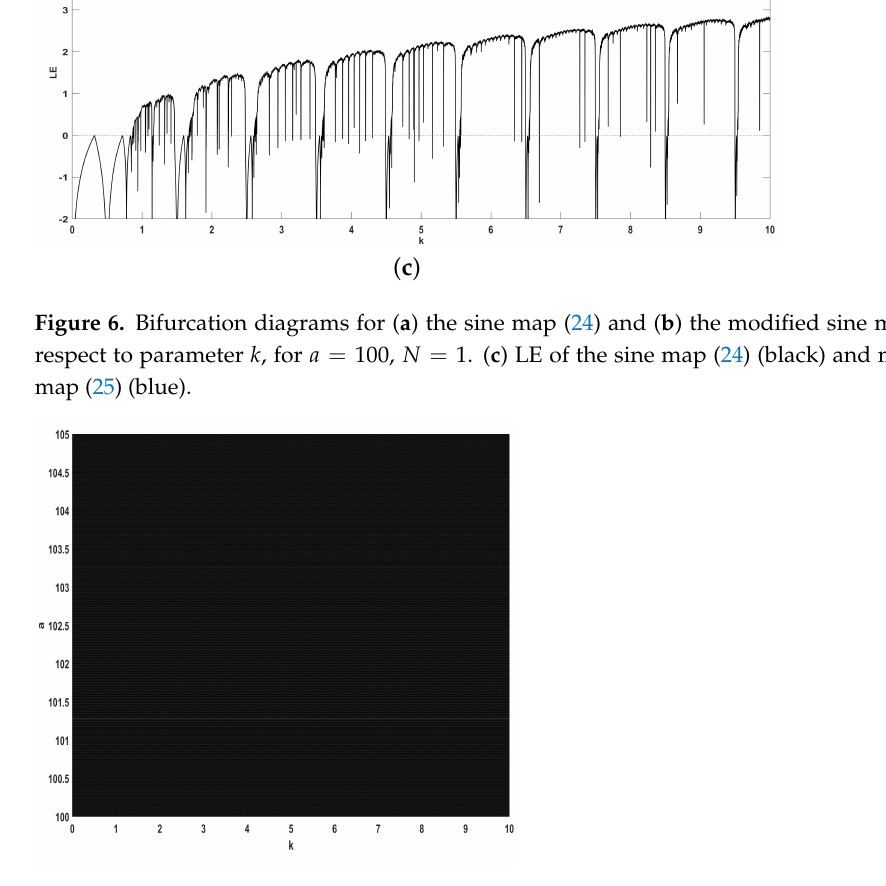
Figure 7. Diagram depicting the parameter pairs ( k , a ) of (25) that yield chaotic behavior. Black regions depict chaos, while white regions are non-chaotic. As there are no white regions to be seen in the considered parameter range, the modified map has robust chaos. The simulation stepsize for each parameter was set to 0.005.